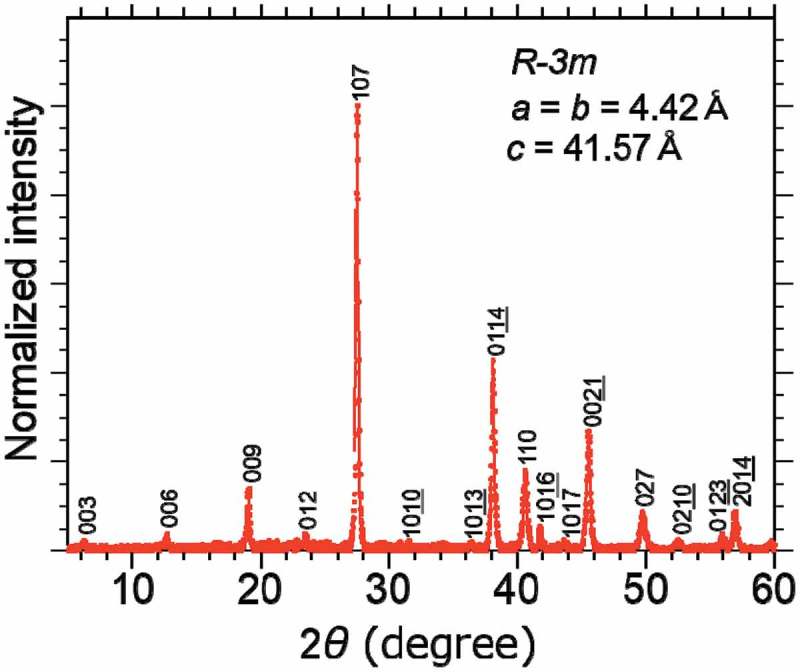
Powder XRD pattern of pulverized PbBi2Te4 single crystal.